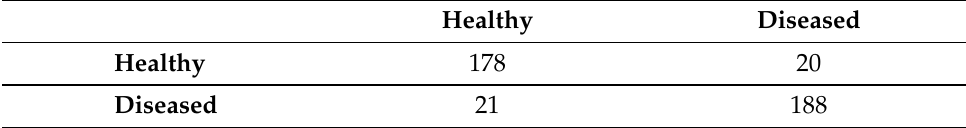
Table 3. Confusion matrix for the validation